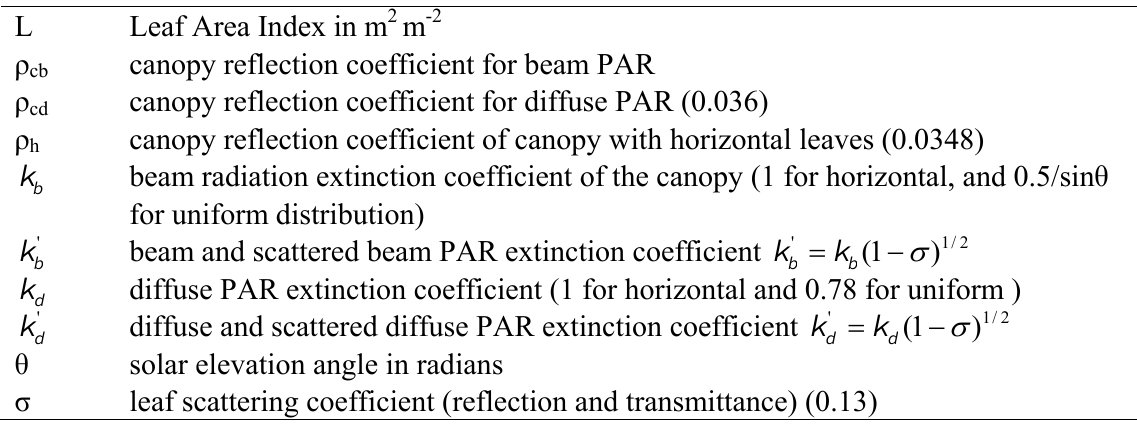
Table 3. Constants, variables and values used in multilayer